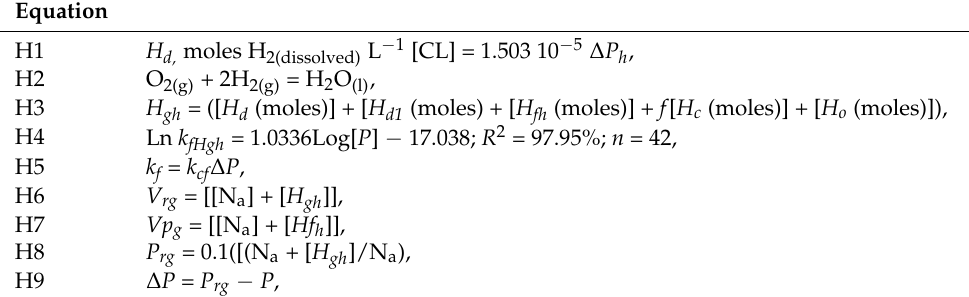
Table 9. Equations used to interpret the observed hydrogen. H fh = moles of free hydrogen (measured); H c = moles of free gaseous alkanes (measured); H o = moles of hydrogen required to remove the O 2 (measured); f = number of moles of H 2 required to produce 1 mole of gaseous alkane (Table 5). The forward rate constant, k fh , is provided in Table 6. k cf = moles product g − 1 ZVM s − 1 MPa − 1 ; ∆ P = driving force, MPa. A g = moles of gaseous alkane in the product gas.